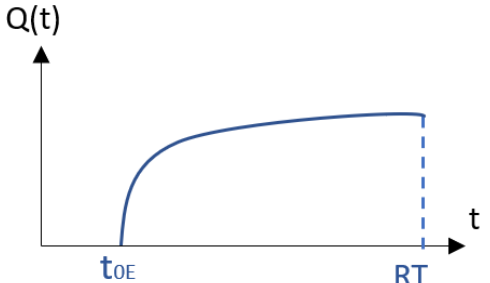
Figure 2. Definition of Q(t) (1D), by following [26,27], (t 0E : time of occurrence of the earthquake E, RT: the repair time, Q(t): recovery function, t: time).